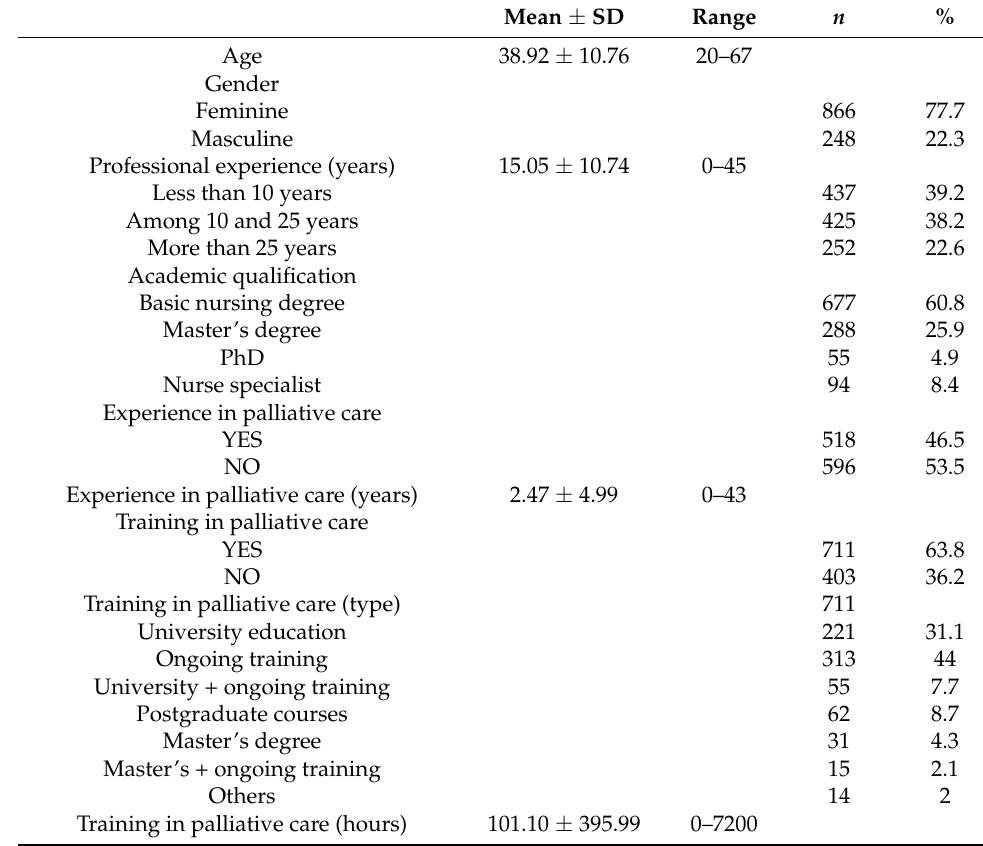
Table 1. Features of the studied